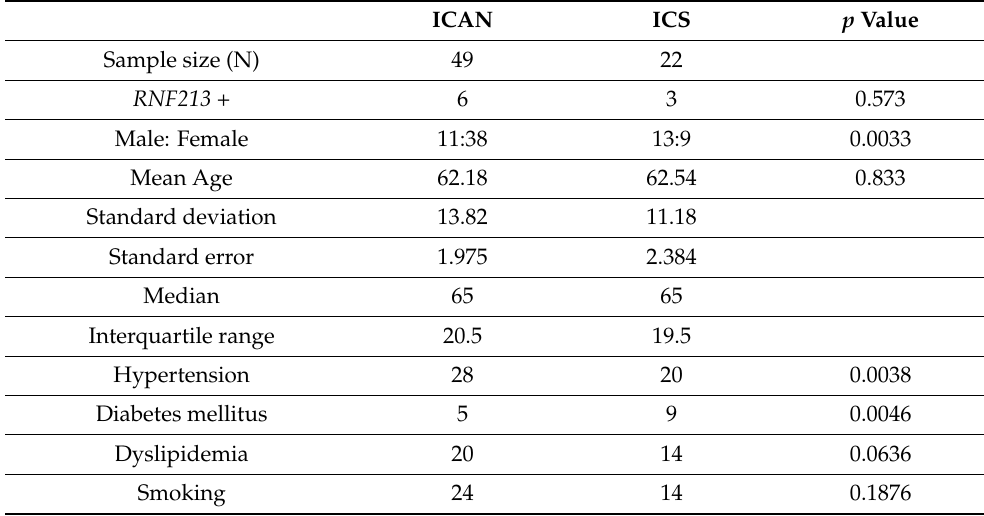
Table 1. Patient characteristics based on the disease